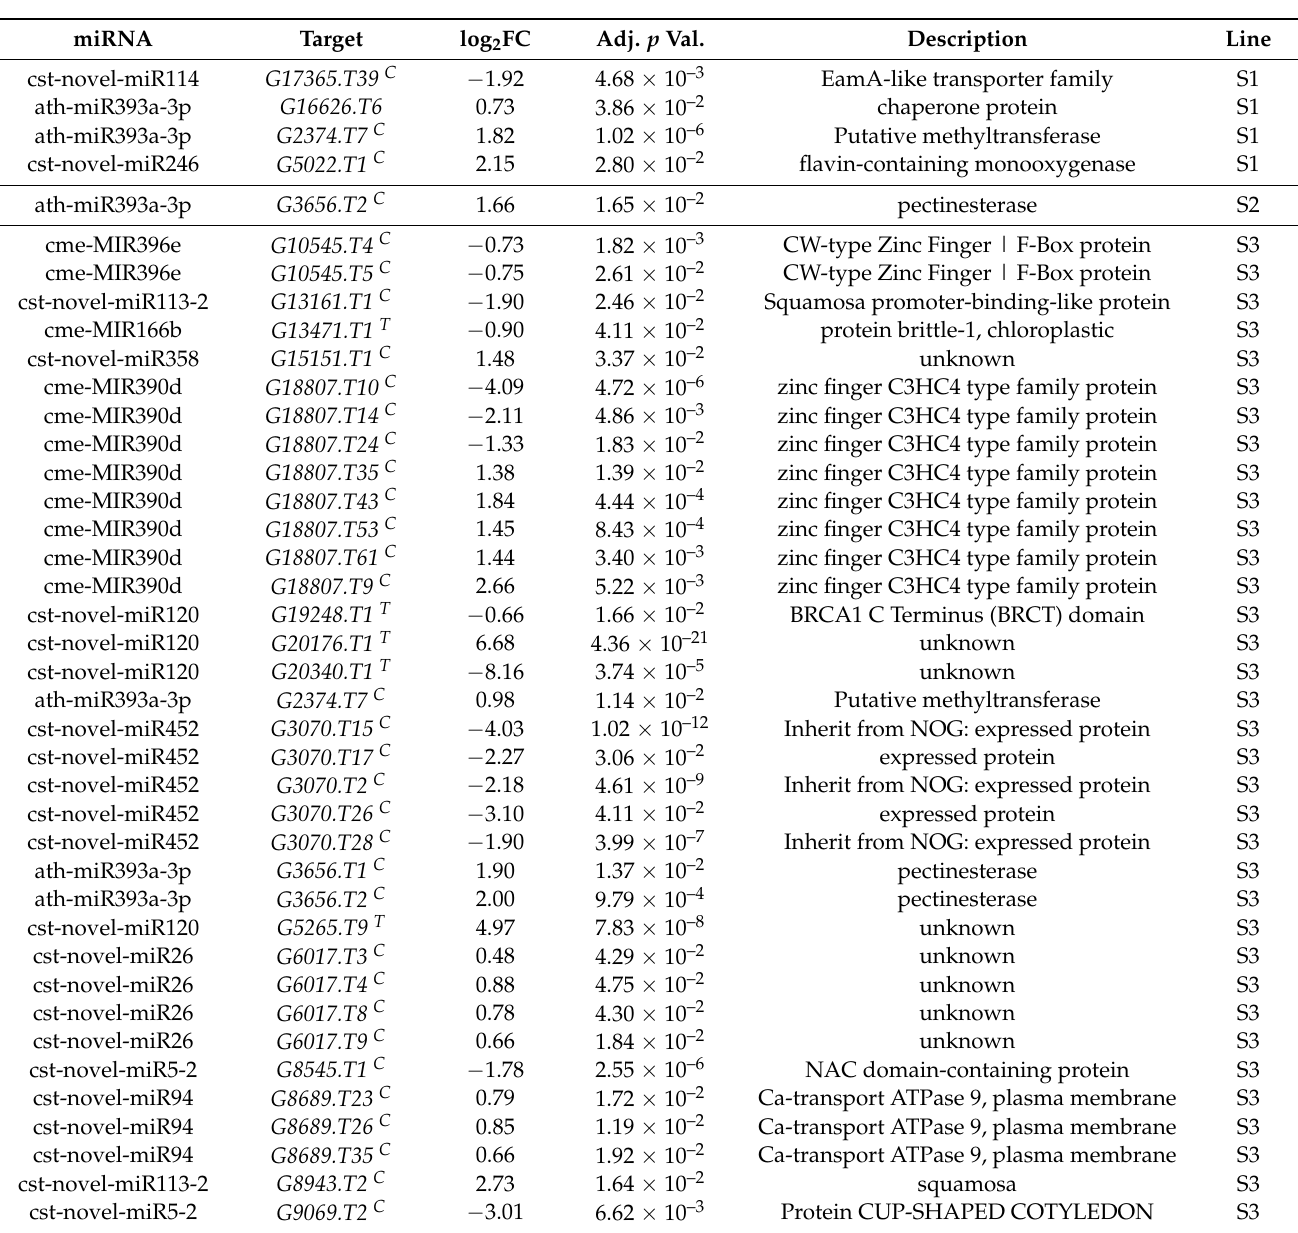
Table 4. Differentially expressed genes that are targets of differentially expressed miRNAs in lines S1, S2 and